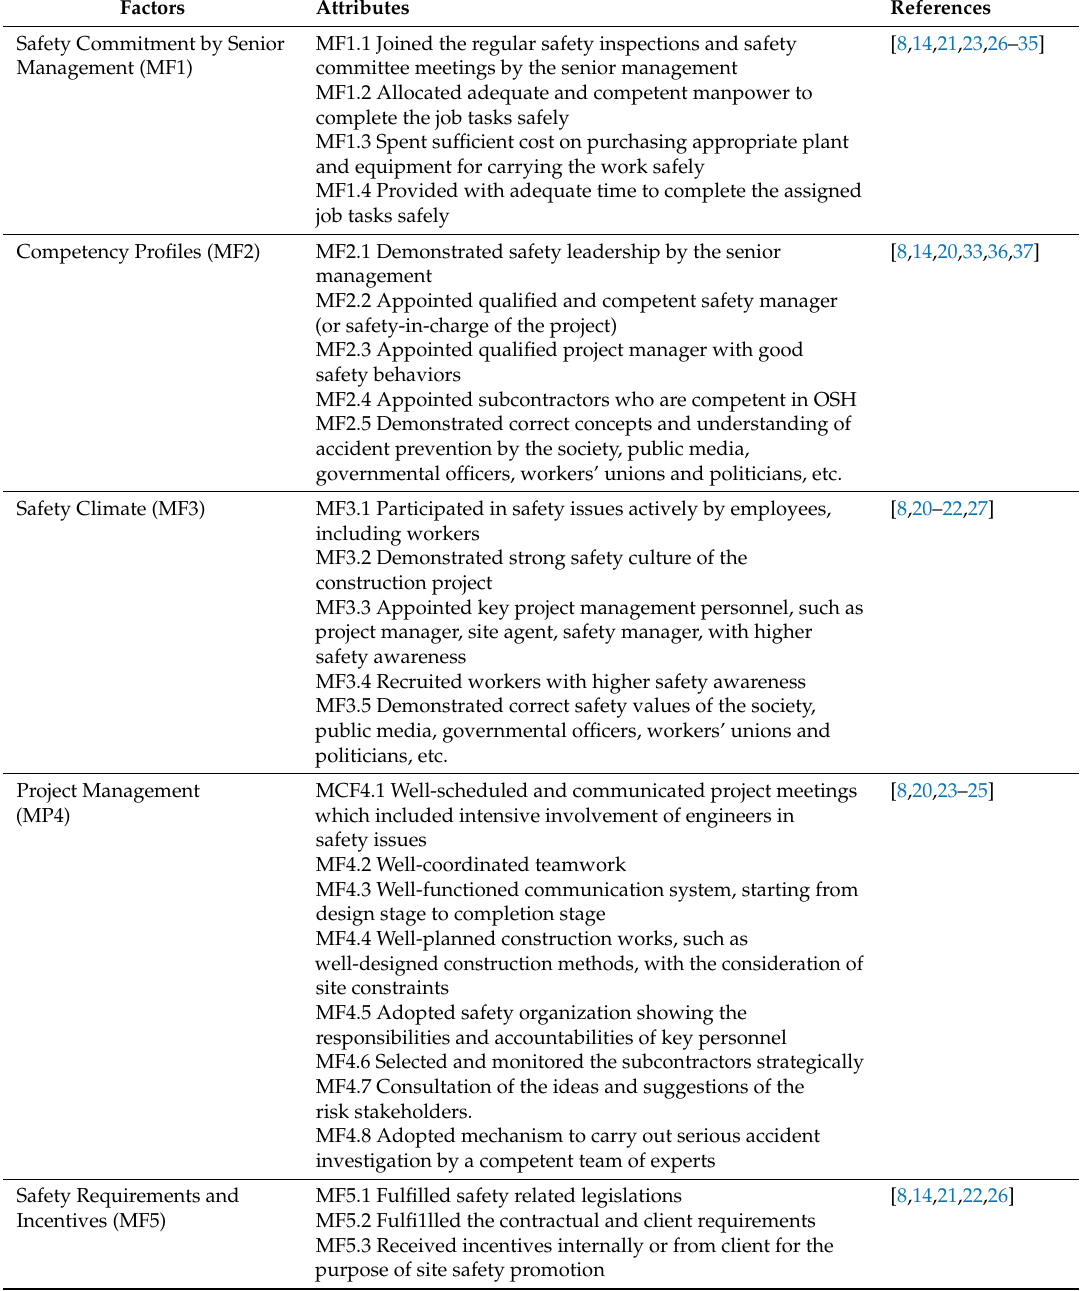
Table 1. Constructs and Initial Measurement Attributes for Motivation Factors of